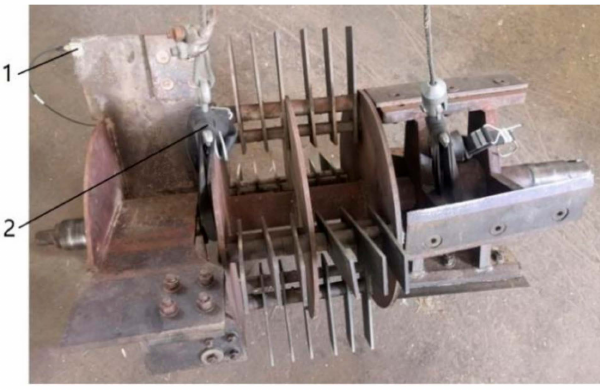
Figure 2. Modal test layout. (1) Suspension point; (2) sensor placement point.